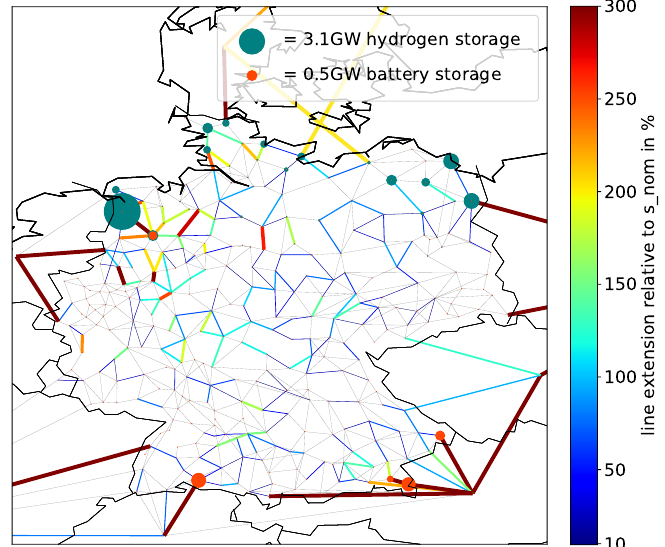
Figure 11. Allocation of grid and storage expansion in the EHV and HV level for the scenario eGo 100 . s_nom refers to the original nominal thermal limit capacity of each line. A net extension of 300% is synonymous with a new optimized capacity of four times the original capacity. Table 7. Overview of overnight investment costs for grid and storage expansion for each scenario and grid level.The MV+LV results refer to the Flex approach. Transformer costs are included in each aggregated grid level - HV/MV transformer are assigned to the MV+LV